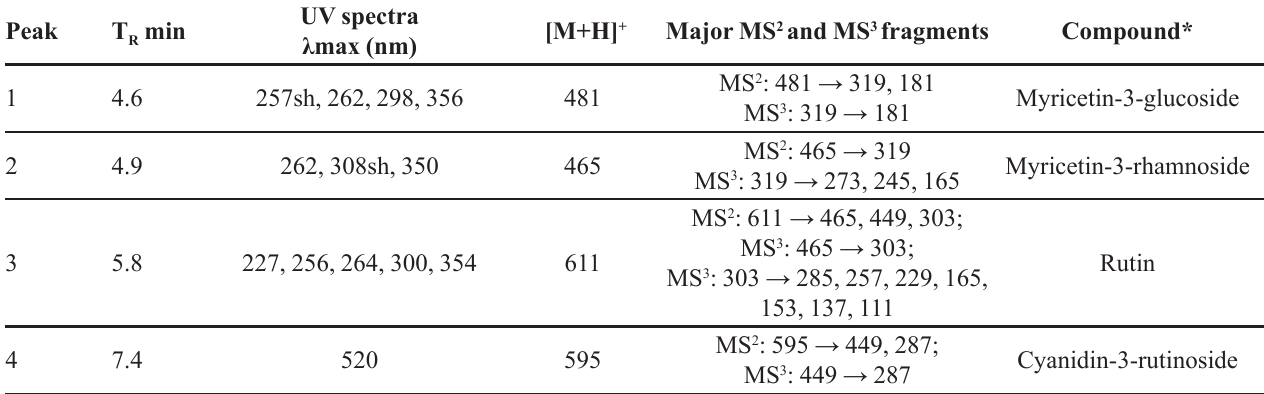
*Peak compared with